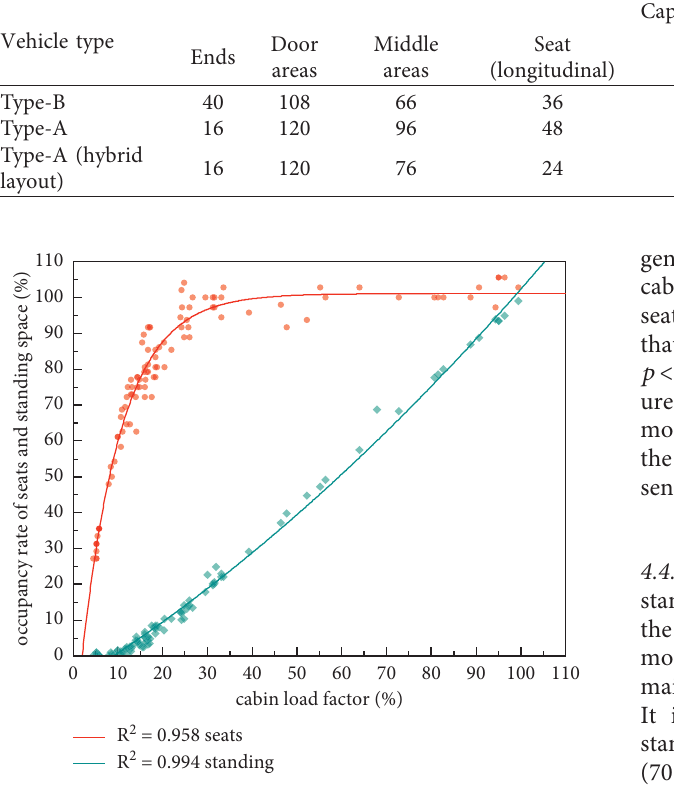
Figure 3: Growth curve of the occupancy rate of seats and standing space.